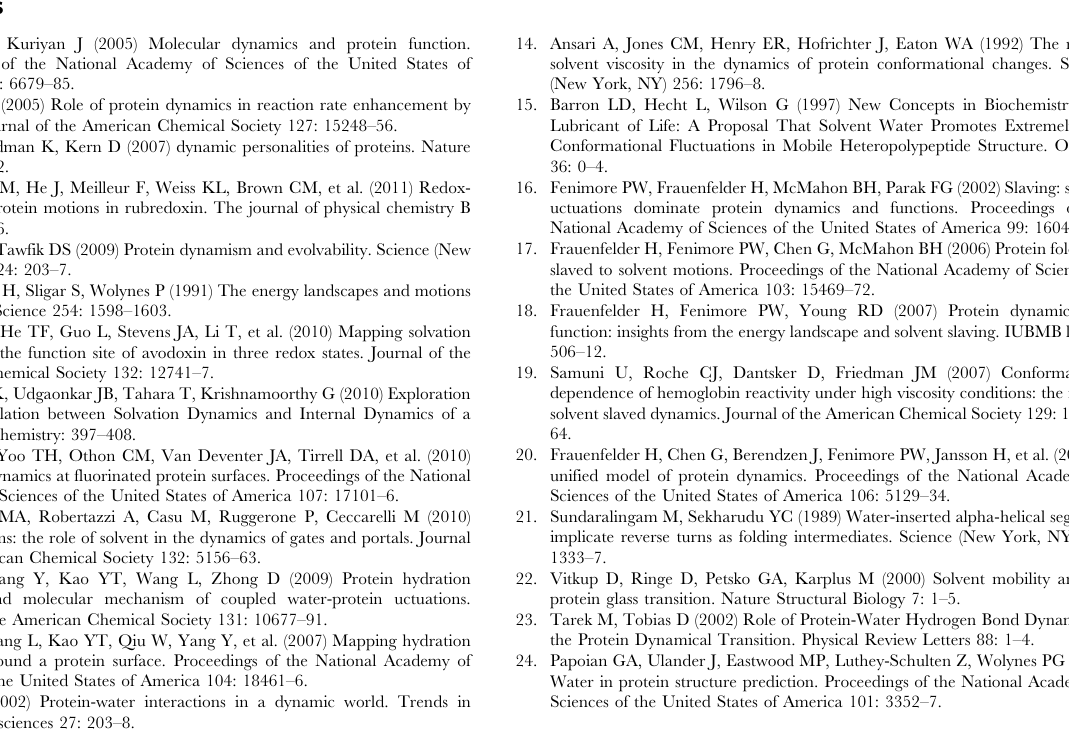
Figure S6 The relationship between r (correlation coefficient between E p and E p { w ) and net effects of water molecules on local PES ( s E